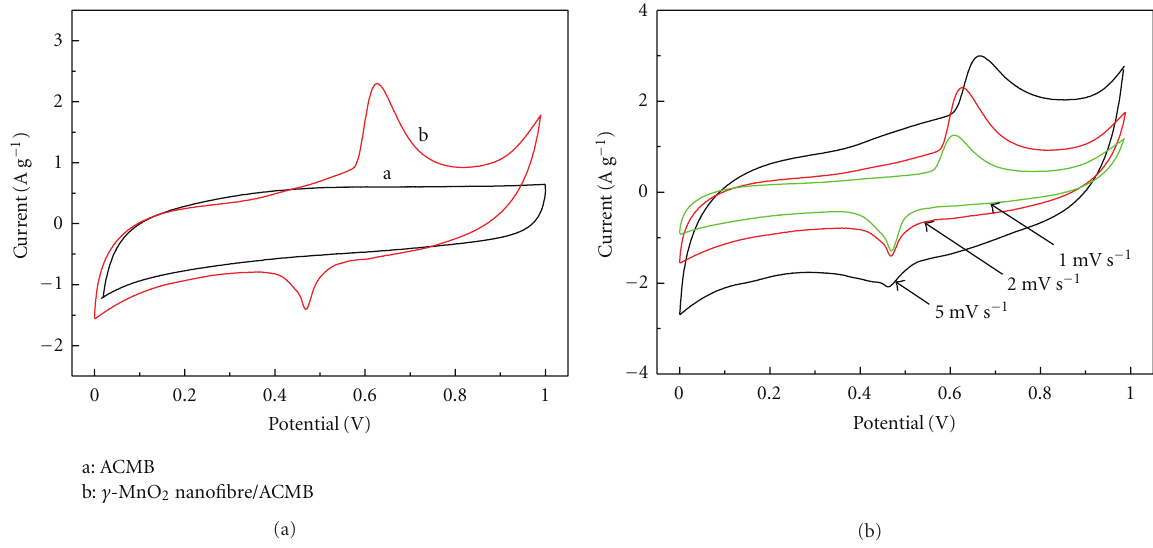
Figure 3: Cyclic voltammograms of (a) ACMB and γ -MnO 2 nanofibre/ACMB composite at a scan rate of 2mVs − 1 and (b) γ -MnO 2 nanofibre/ACMB composite at di ff erent scan